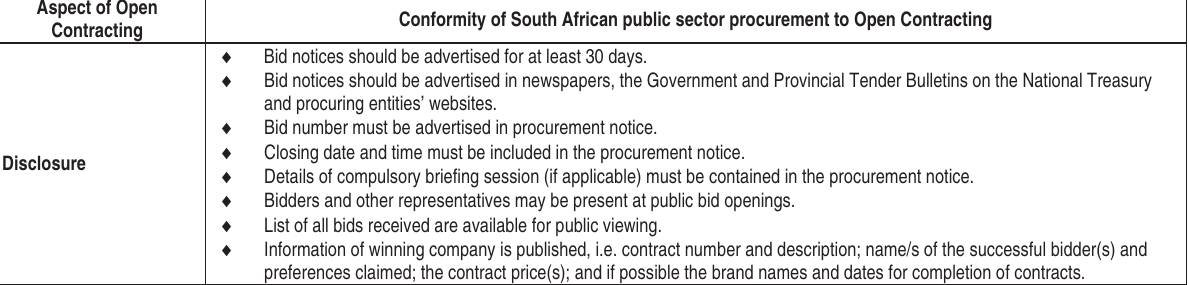
Table 1. Theoretical framework for disclosure in South African public procurement Aspect of Open Contracting